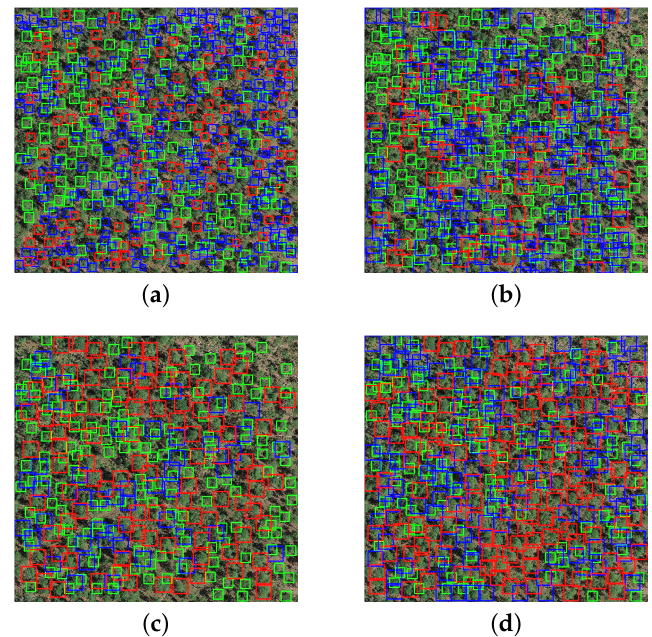
Figure 12. Results of different methods in Test Area 3: ( a ) Region-growing; ( b ) Template-matching; ( c ) Convolutional neural network; and ( d ) Progressive cascaded convolutional neural network.